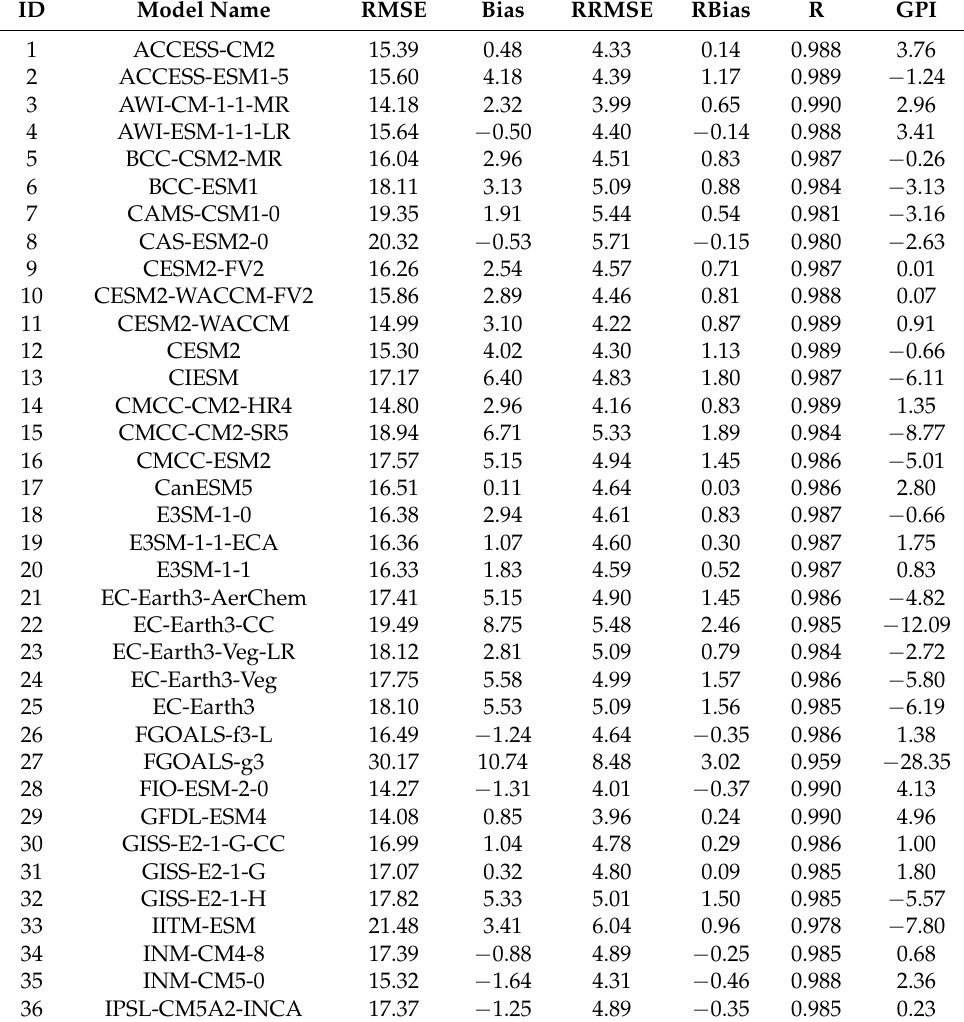
Table 3. Evaluation of global monthly SULR simulations from the 51 CMIP6 GCMs using the Clouds and the Earth’s Radiant Energy System, Energy Balanced and Filled (CERES EBAF) data from 2000 to 2014 at 1 ◦ × 1 ◦ grid scale (in units of W m − 2 for RMSE and Bias, % for RRMSE and RBias,